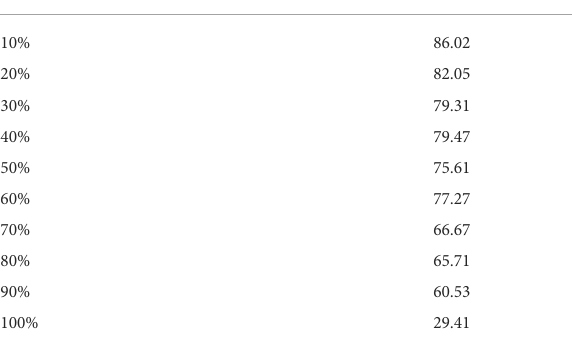
TABLE 2 Percentage of